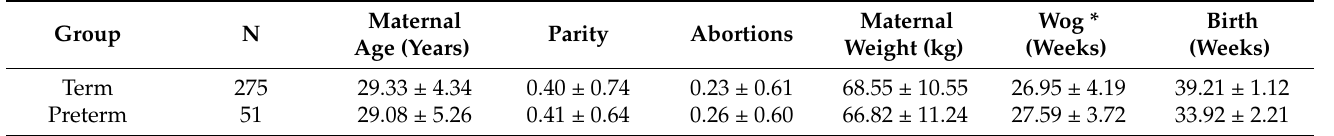
Table 1. Demographic description of the both databases (TPEHG DB and TPEHGT DS).